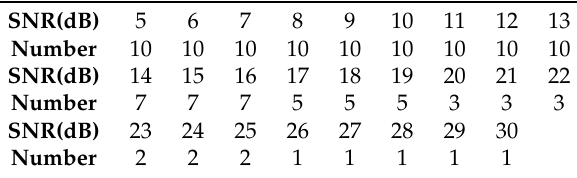
Table 3. Additional number of symbols for different SNR.